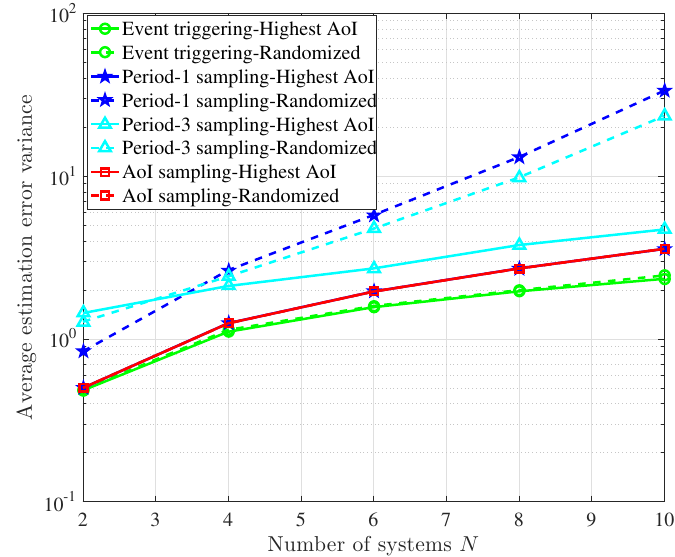
Figure 4. Comparison of estimation error variance for various sampling/scheduling architectures.